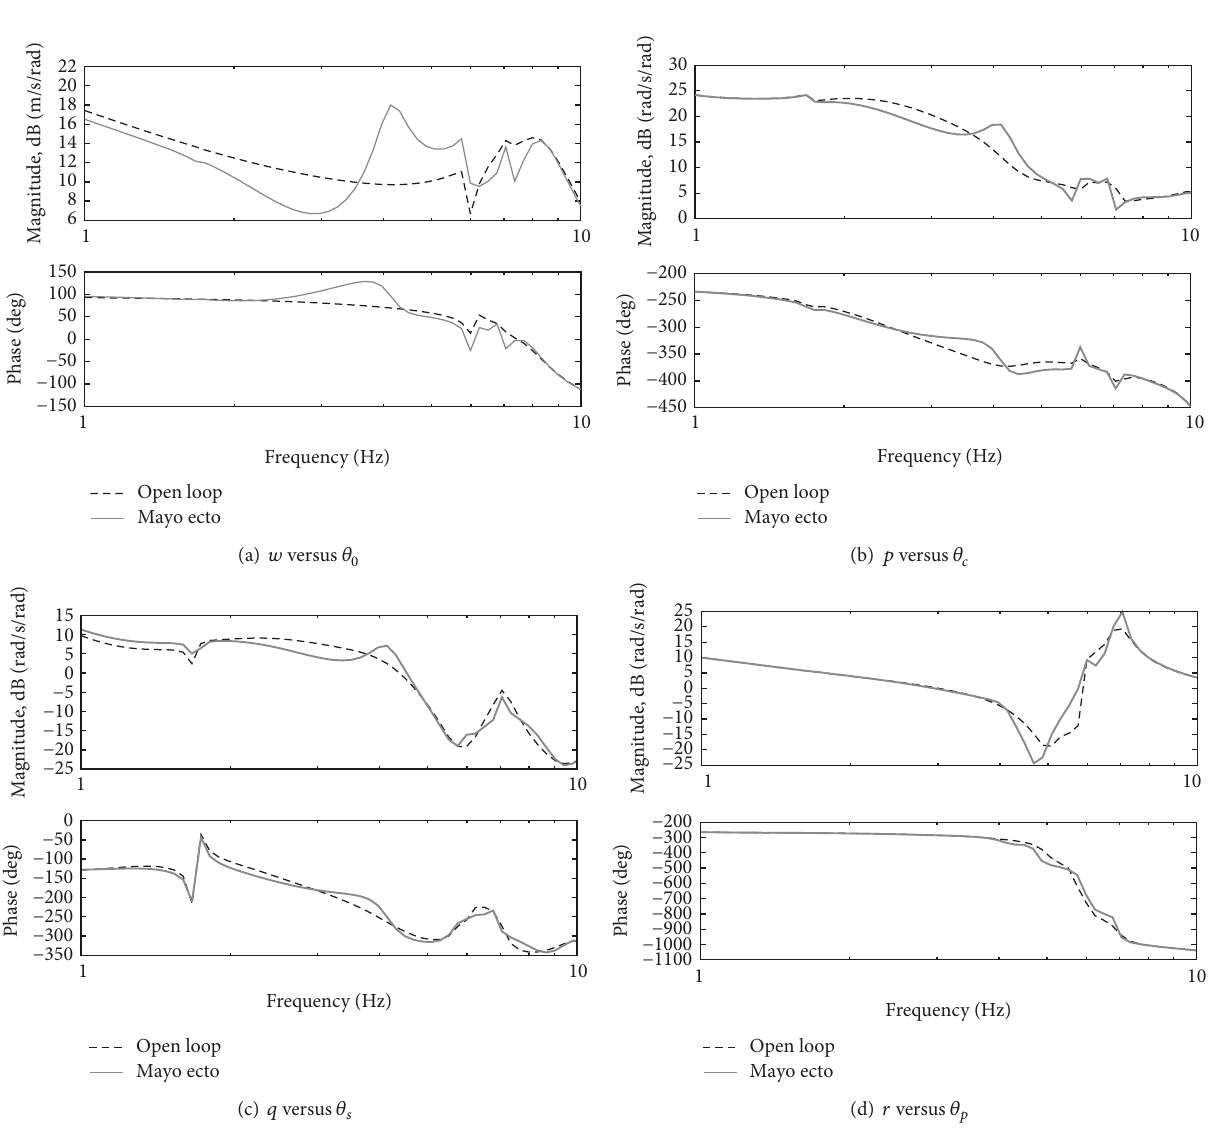
Figure 9: Helicopter transfer functions for in-the-loop and out-of-the loop collective control